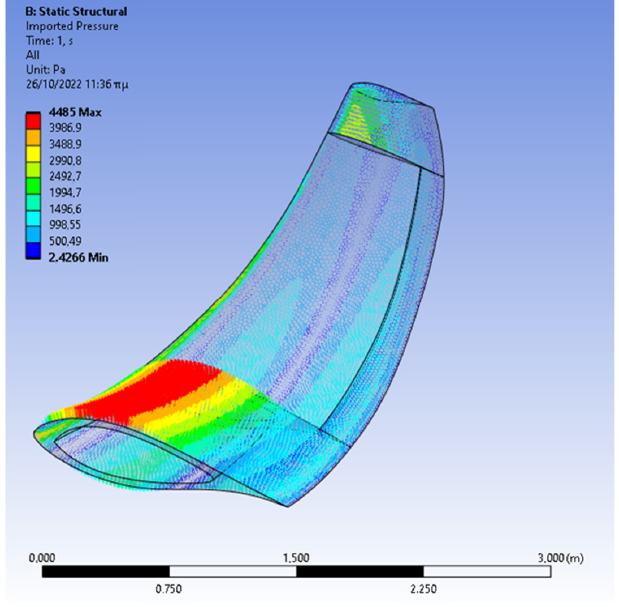
Figure 6. Pressure distribution data generated from CFD study.